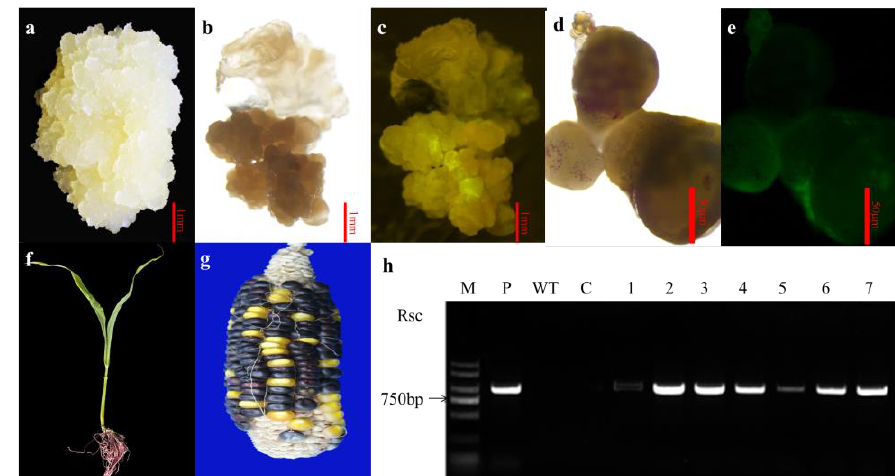
Figure 3. Regeneration of transgenic maize lines from immature embryogenic calli, and molecular and phenotypic identification of transformants. ( a ) Callus derived from an immature embryo and used as transformation receptor; ( b ) Fluorescence-positive calli grown on selection medium under the white light; ( c ) Fluorescence-positive calli phenotype was detected on the DR-46B Dark Reader transilluminator; ( d ) Multiple green spots were visible on the embryogenic calli in regeneration medium; ( e ) Fluorescence phenotype was detected with a fluorescent protein macro detector set; ( f ) Regeneration of putative transgenic plants; ( g ) Rsc-positive seeds of the regenerated plant; ( h ) PCR analysis showing positive transplants. M, BM2000 DNA marker; P, Plasmid DNA; WT: Wild type control; C: Transgenic negative control; lanes 1–7, different plants from different transformants.